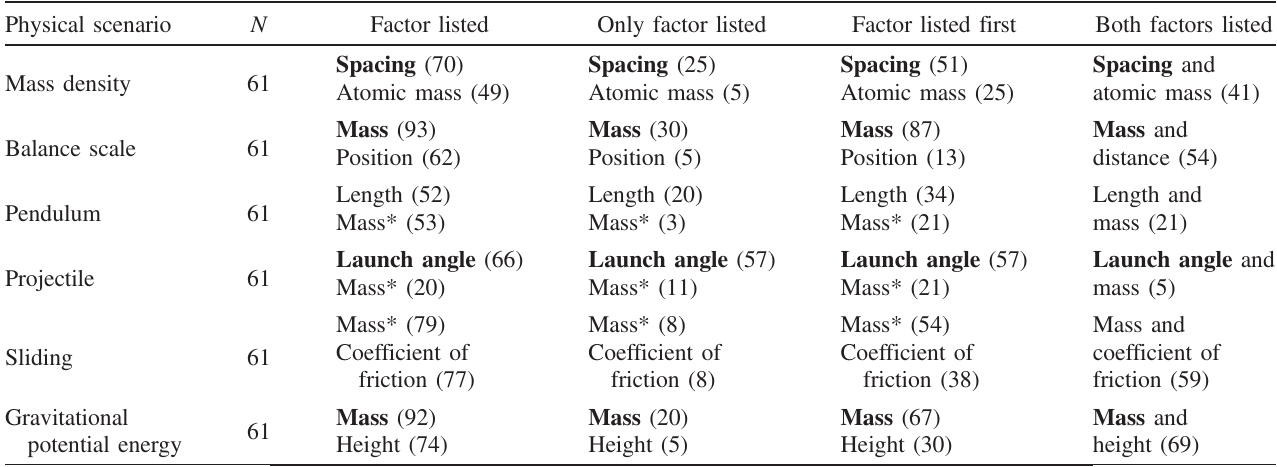
TABLE VIII. Experiment 3 recall condition results. The two most common factors listed as explaining the outcomes for each task. Percentages of participants explicitly listing (recalling) each combination are in parentheses. The factors with significantly relatively higher accessibility (strength) are in bold. Note that the factors with asterisks are not physically